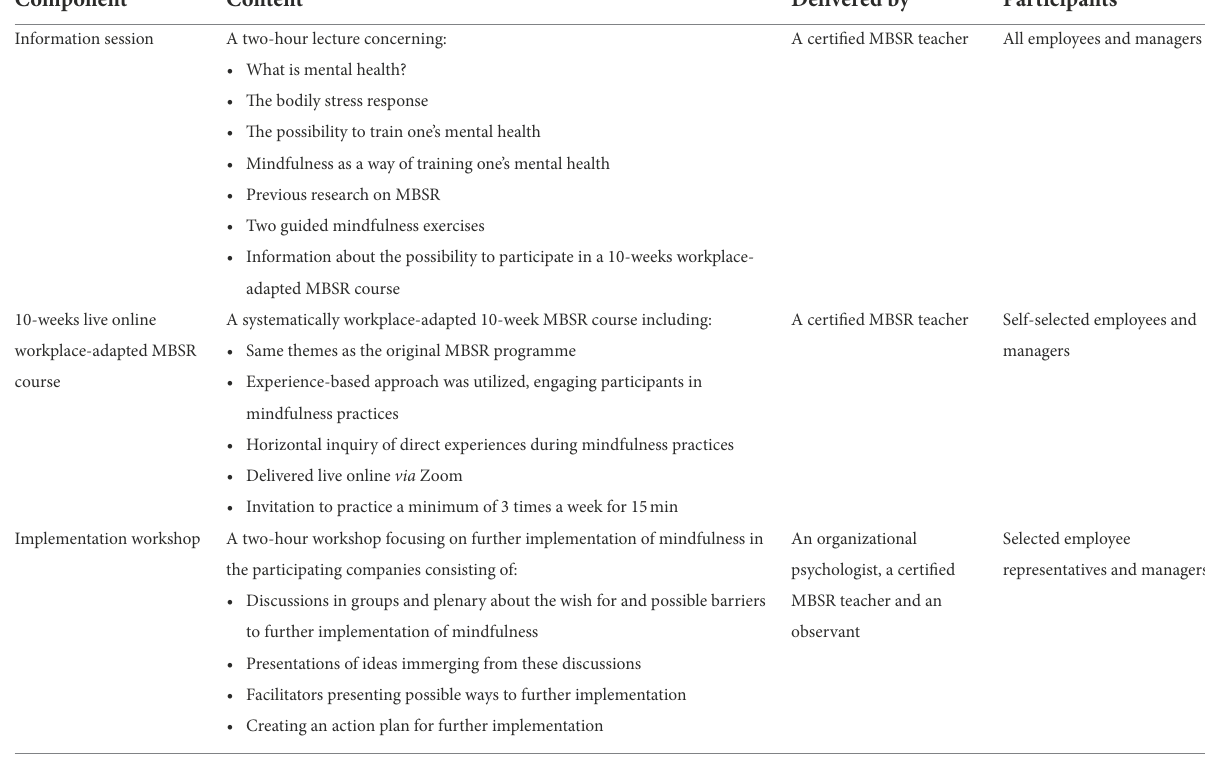
TABLE 1 Intervention components and content.